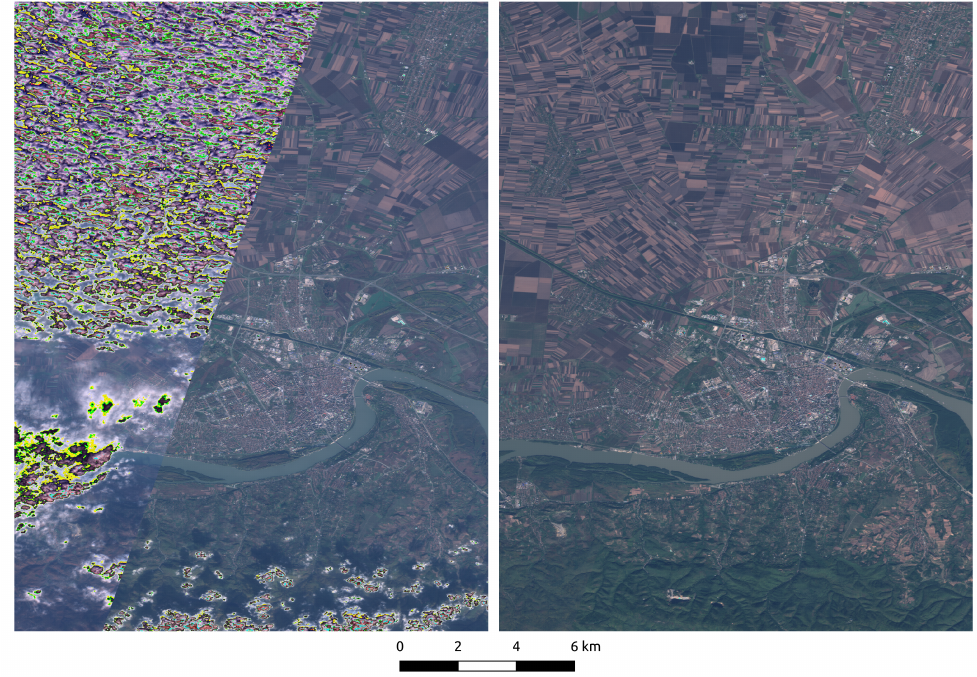
Figure 10. Novi Sad region for October/November of 2021—high vs. low CC.